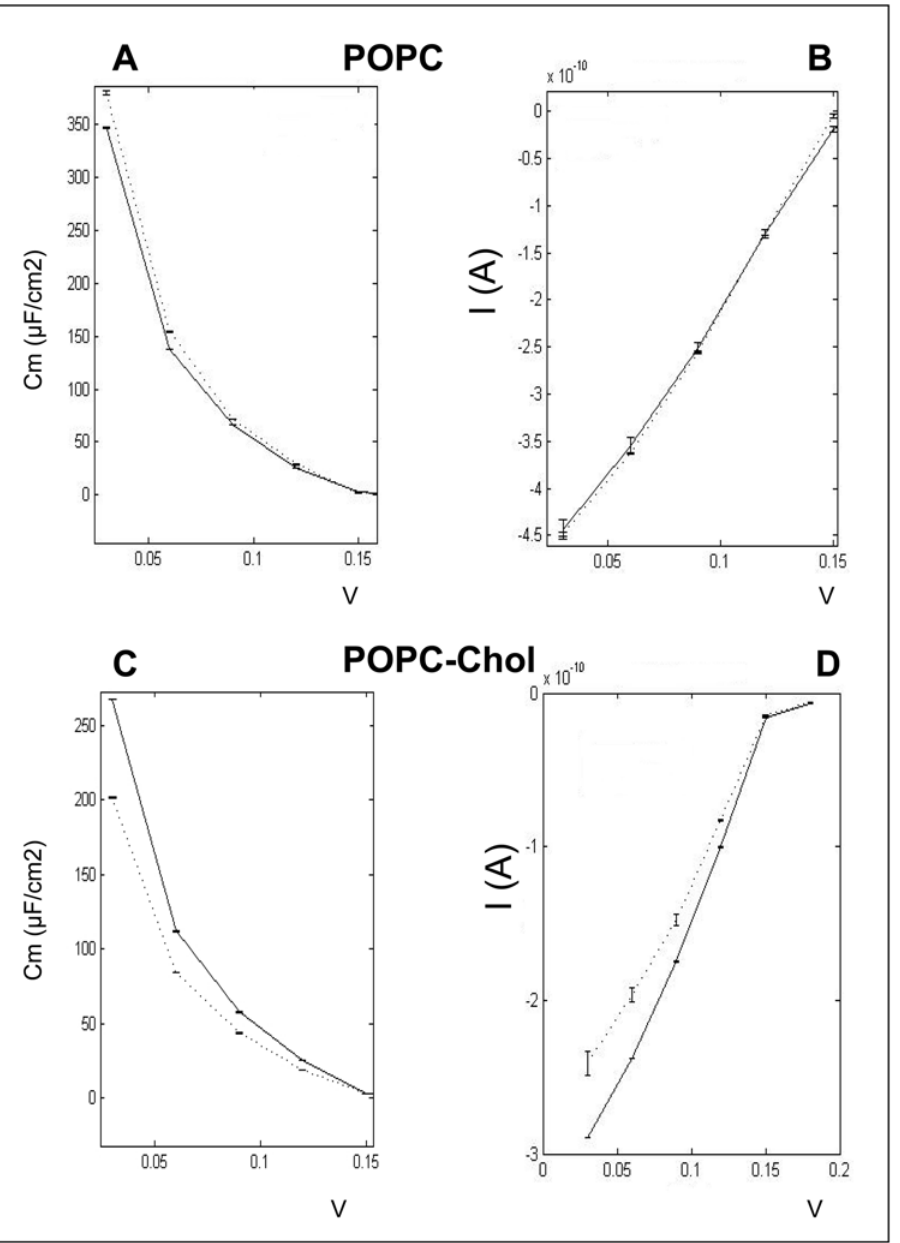
Figure 8. Modification of bilayers electrical properties. A–D . dotted line, control; solid line, after AEA injection. Intensity-Voltage curves were obtained from the relaxation tail currents plotted against voltage, and current reading at 225 ms and 425 ms (POPC and POPC-cholesterol respectively). Capacitance-Voltage curves, I 0 reading was also at 225 and 425 ms, and I t 100 ms later. Error bars were calculated after current acquisitions from six repeated protocols, from the same membrane, and then fed to the analysis